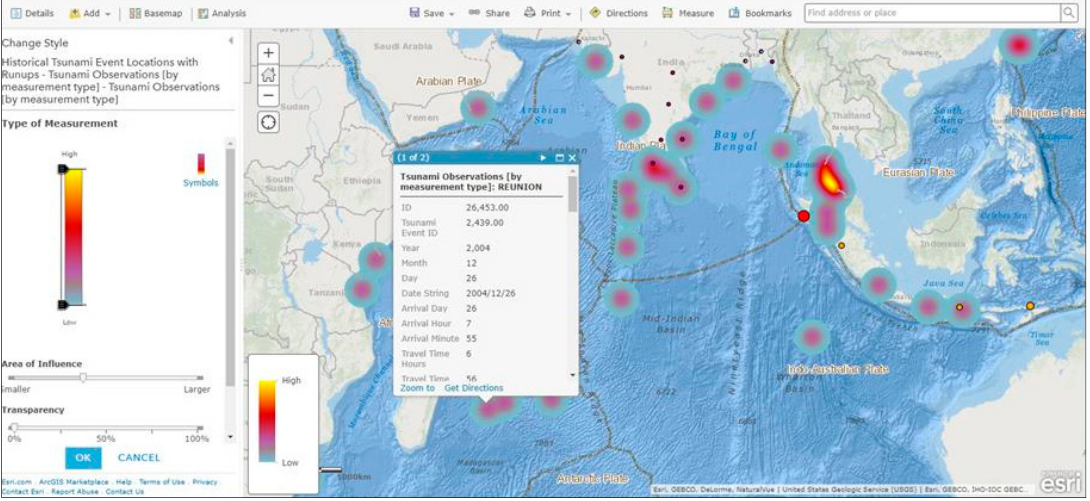
Figure 8. Exploring tsunami hotspots.